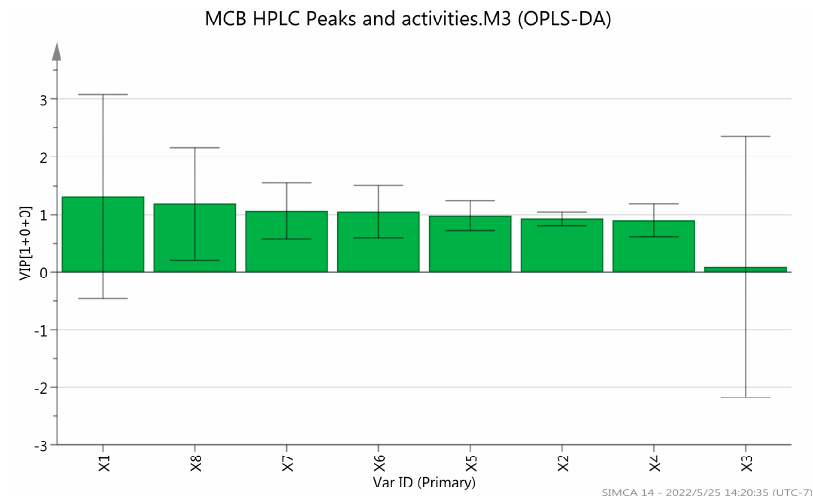
Figure 13. VIP of MCB extracts and fractions. X1 (Peak 1): caffeic acid, X2 (Peak 2): quercetin 3-O-galactoside, X3 (Peak 3): isoquercetin, X4 (Peak 4): astragalin, X5 (Peak 5): rosmarinic acid, X6 (Peak 6): aromadendrin-3-O-rutinoside, X7 (Peak 7): rosmarinic acid-3-O-glucoside, X8 (Peak 8): kaempferol-7-O-glucoside.